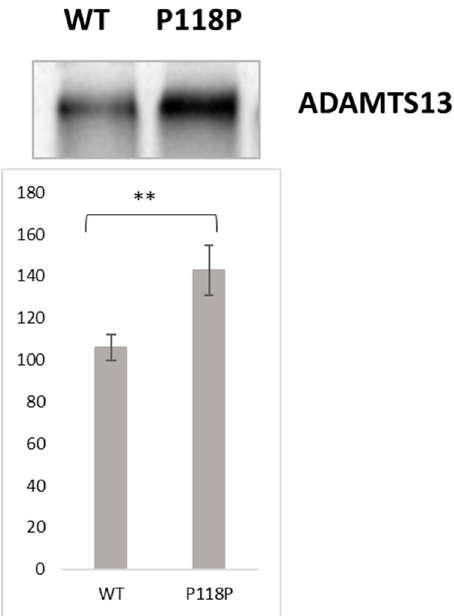
Figure 1. In Vitro translation analysis of wild-type (WT) and c.354G > A variant ADAMTS13 transcripts. Top—representative autoradiogram of WT and p.P118P (c.354G > A) variant in vitro translation products. Bottom—the graphical representation of intensities of in vitro translation products. ** p < 0.005 by Student’s t -test (Graphpad), Data represents the mean ± SEM of three independent experiments. Significantly higher translation of c.354G>A variant relative to WT